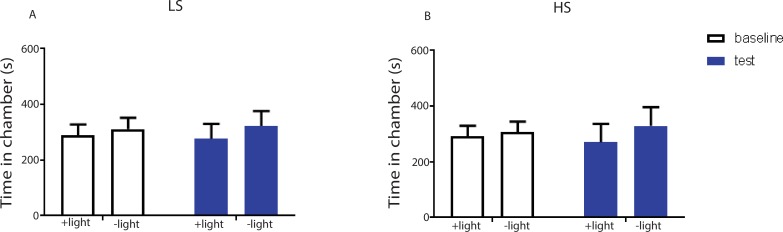
Light treatment of the ACC injected with an YFP-only vector did not impact conditioned place aversion.We injected a viral vector that expressed only YFP without any opsins into the ACC. We applied laser light to the ACC in rats injected with this virus during the CPA tests. (A) During the conditioning phase of the CPA assay, we paired one chamber with light treatment and LS, and the opposite chamber with LS alone. We did not observe any preference or aversion for the chamber paired with light treatment. n = 7; p=0.6875, paired Student’s t test. (B) During the conditioning phase of the CPA assay, we paired one chamber with light treatment and HS, and the opposite chamber with HS alone. We did not find any preference or aversion for the chamber paired with light treatment. n = 7; p=0.6149, paired Student’s t test.